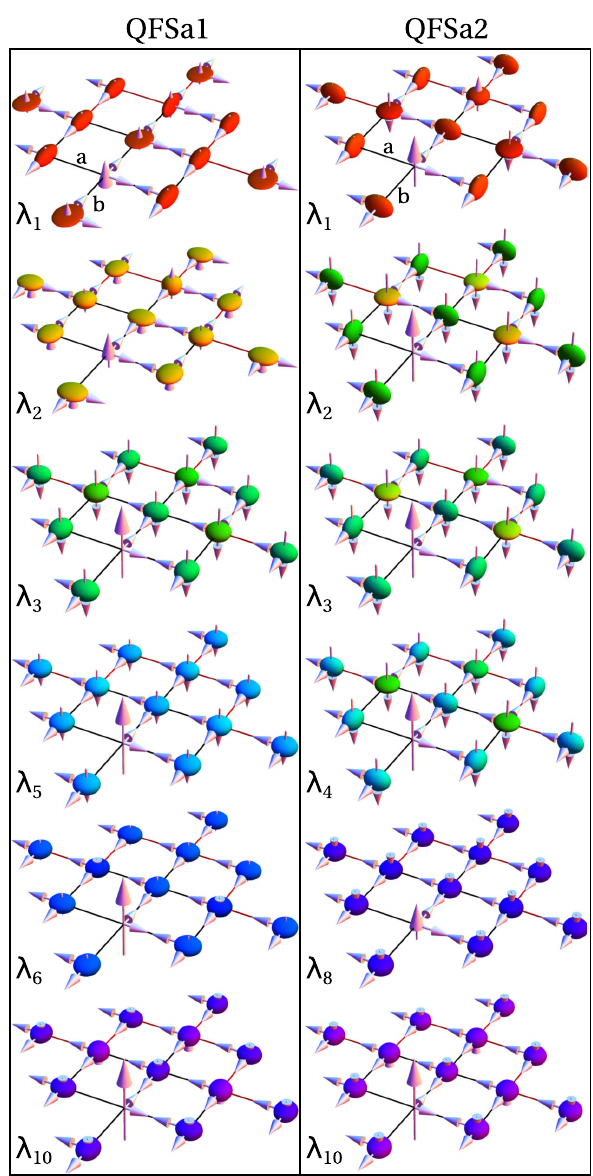
FIG. 15. Evolution of the ground-state configurations for the QFS a 1 and QFS a 2 phases for selected increasing values of spin- orbit coupling λ ; see Eq. (28). Arrows and ellipsoids indicate the m spin-orbital state at a given site i . The color map indicates the strength of the average spin orbit h ~L · ~S ; i.e., red, yellow, green, i i i blue, and violet correspond to the growing amplitude of the above local correlation